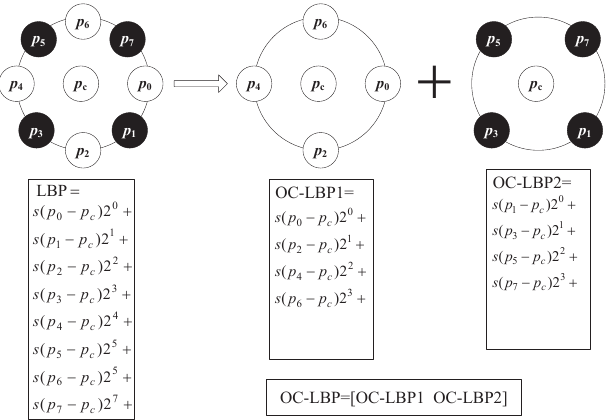
Figure 2. Calculation of local binary patterns (LBP) and the orthogonal combination of local binary patterns (OC_LBP) with eight neighboring